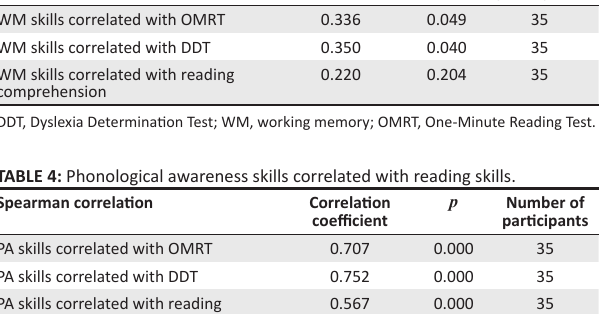
TABLE 3: Working memory skills correlated with early reading skills. Spearman correlation